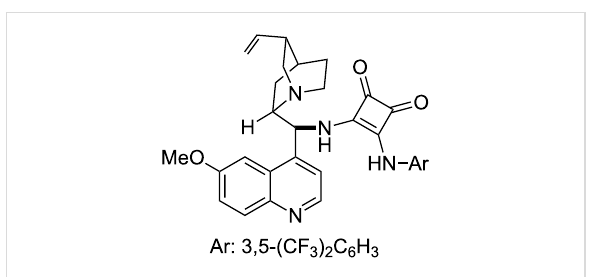
Figure 7: Structure of cinchona alkaloid-based squaramide catalyst.